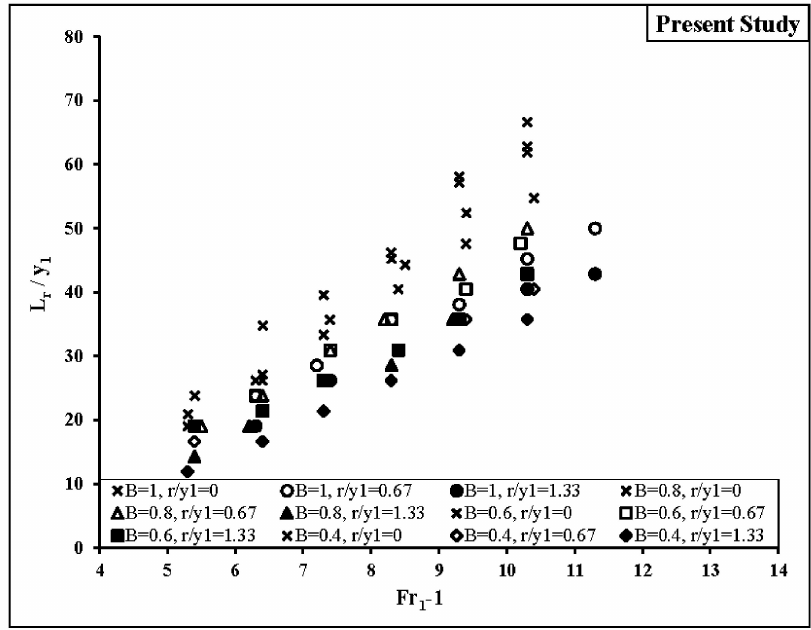
Figure 8. Relationship between the ratio of L r / y 1 and ( Fr 1 − 1) for all experimental